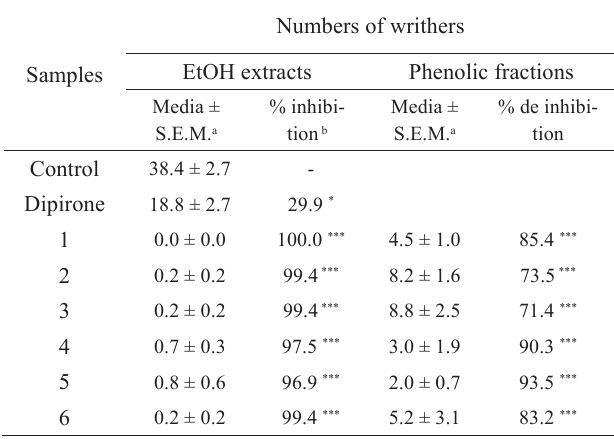
Table 1 . Effects of injections of ethanolic extracts and phenolic fractions of geopropolis on abdominal constrictions induced by acetic acid in